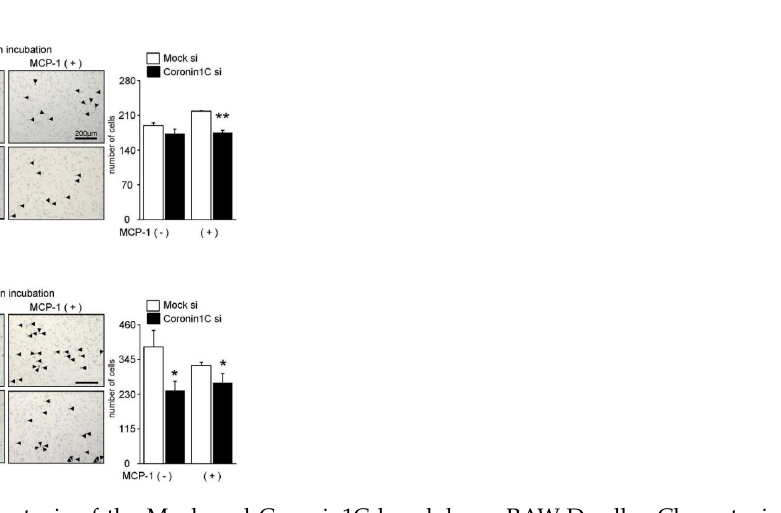
Figure 6. Migration of the mock and Coronin1C-knockdown RAW-D cells. ( a ) Mock and Coro- nin1C-knockdown RAW-D cells seeded onto a 6-well plate were analyzed by time-lapse video mi- croscopy. Micrographs of time-lapse imaging showing cell tracks. Representative plots of approxi- mately 15 cells of mock and Coronin1C-knockdown RAW-D cell migration tracks for a total dura- tion of 12 h/track. The data and pictures are representative of three independent experiments. ( b ) The distance traveled between positions (path length) of 100 cells. * p < 0.05, compared with the mock cells. ( c ) Average migration speed of 100 cells * p < 0.05, compared with the mock cells.